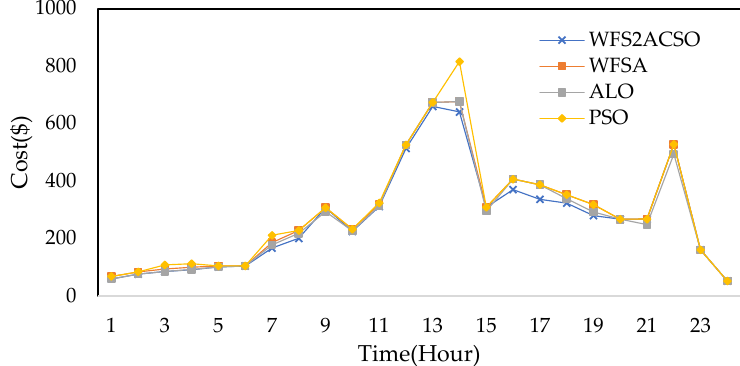
Figure 15. Cost comparison of various techniques for commercial area.